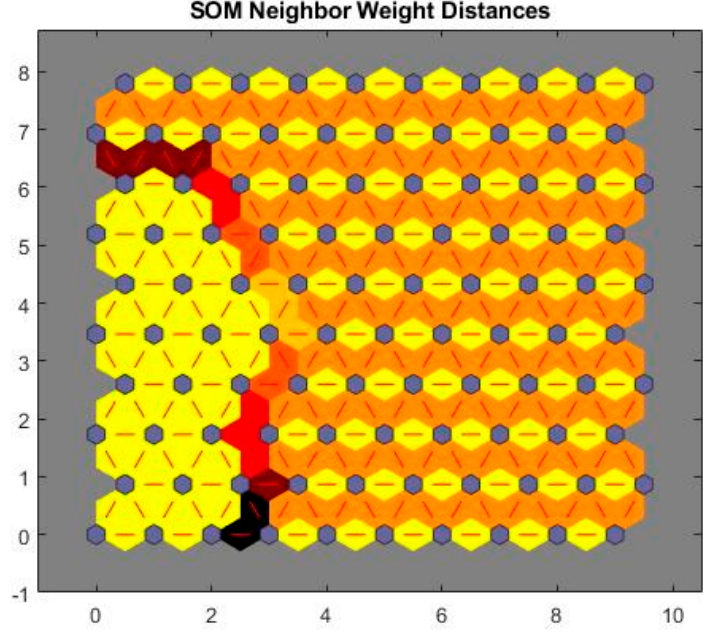
Figure 9. Weight Distance.